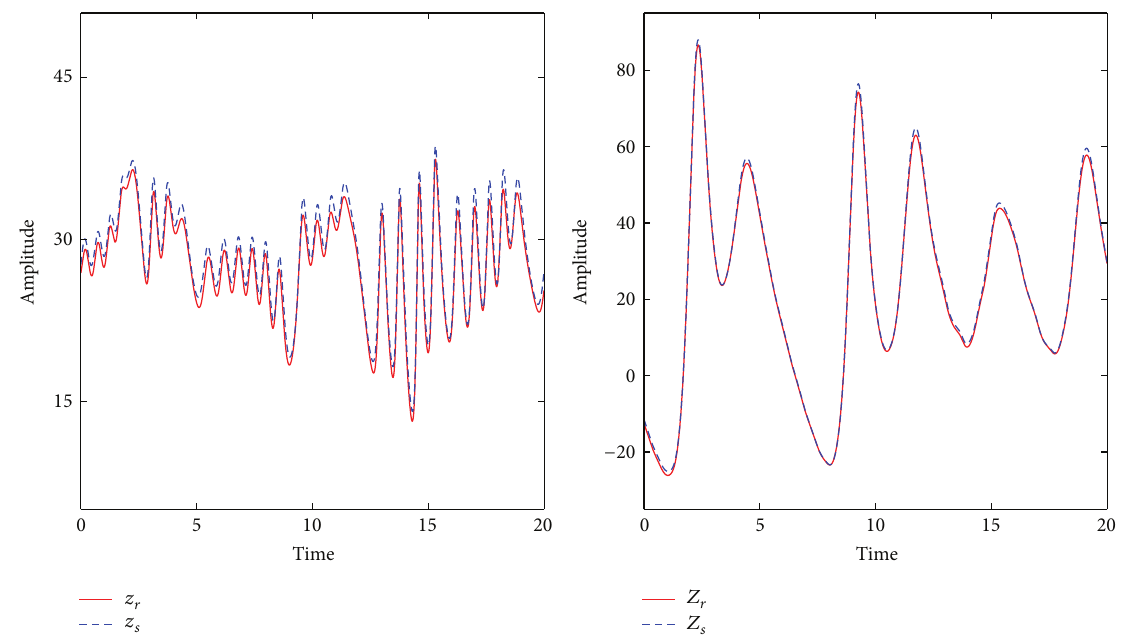
Figure 12: Original trajectory (in red) and pseudoorbit (in blue) for the fast 𝑧 and slow 𝑍 variables for 𝑐 0 = 0.8 .